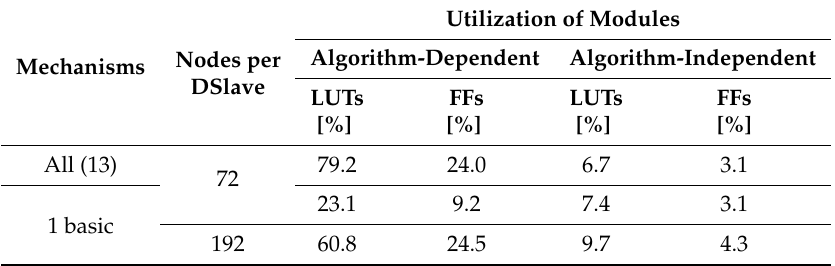
Table 5. Resource utilization of algorithm-dependent and algorithm-independent modules of the design (results obtained for 2 bits dedicated to encode the type of